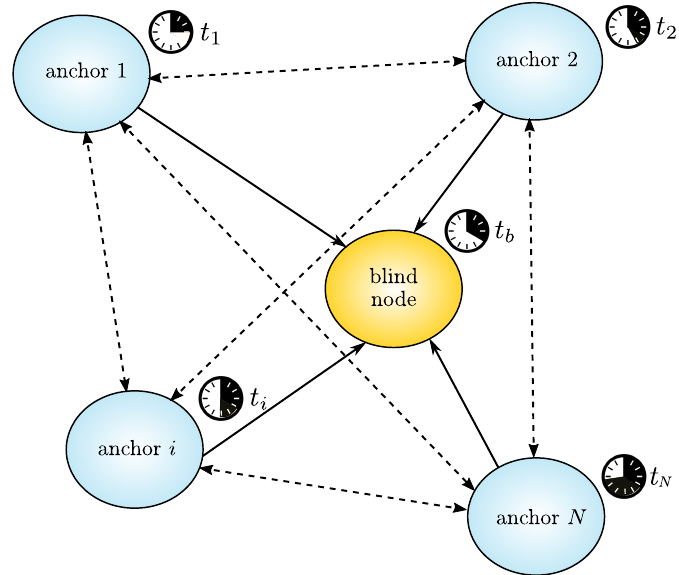
Figure 2. A typical wireless sensor network (WSN) localization problem, with anchors and blind nodes not synchronized to the same clock. Dashed and solid arrows indicate anchor-to-anchor and anchor-to-blind measurements,